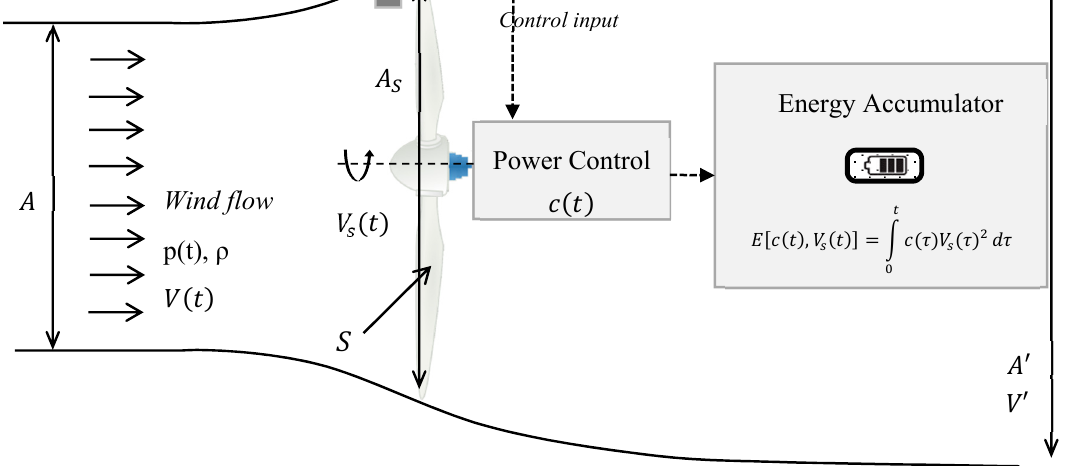
Figure 1. Wind turbine control system.